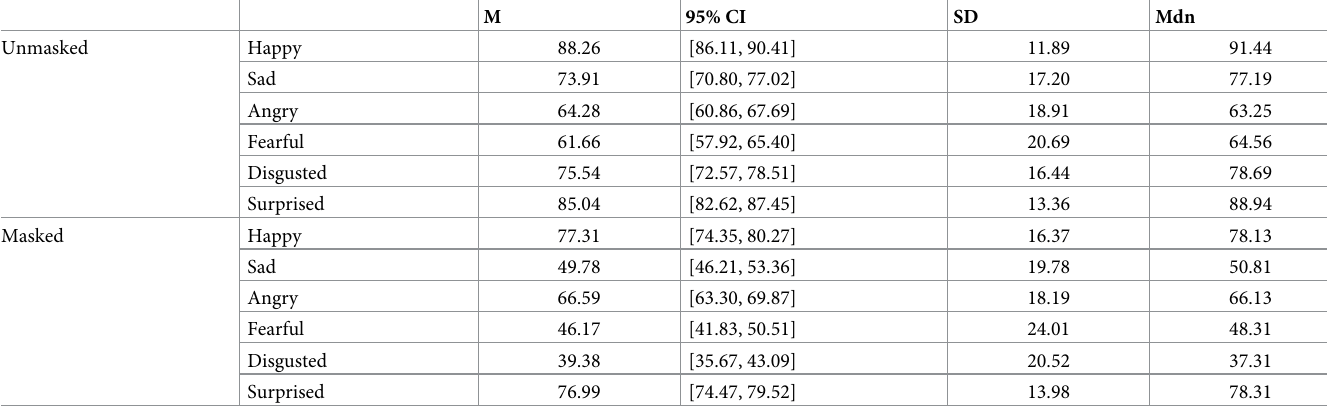
Table 3. Descriptive statistics for intensity ratings of the intended emotions of unmasked and masked